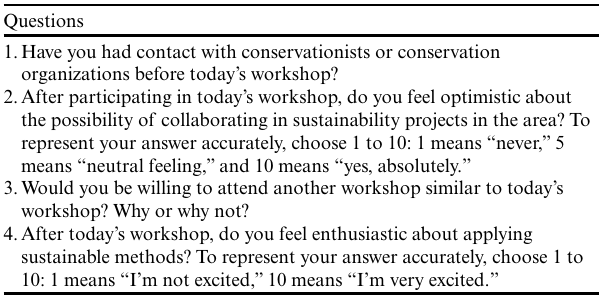
Table 4 . Exit survey questions for dialogue